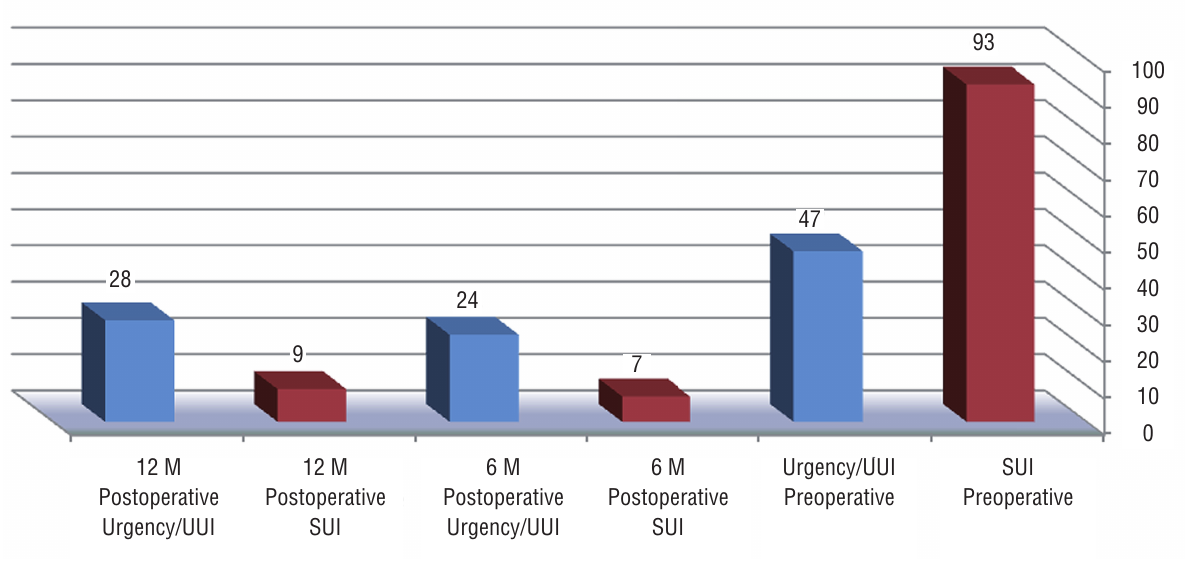
figure 1 - stress urinary incontinence, urgency, and urgency urinary incontinence preoperatively, 6 months, and 1 year after MiniArc procedure. suI – stress urinary Incontinence; uuI – urgency urinary